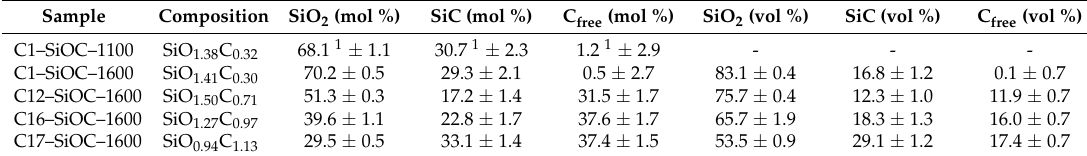
Table 1. Empirical formulae and phase compositions of the silicon oxide carbide (SiOC) samples used in this study [1].